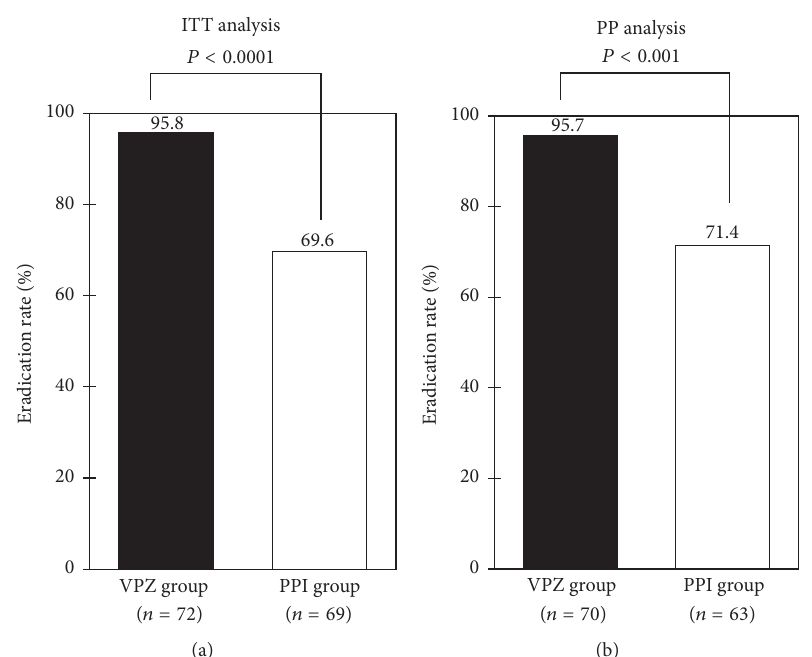
Figure 2: Comparison of eradication rates between vonoprazan- (VPZ-) based regimen and proton pump inhibitor- (PPI-) based regimen. Intention-to-treat (a) and per-protocol (b) analyses. Statistical analysis was performed by 𝜒 2 test. VPZ group, treatment with vonoprazan, amoxicillin, and clarithromycin; PPI group, treatment with rabeprazole or lansoprazole, amoxicillin, and clarithromycin.